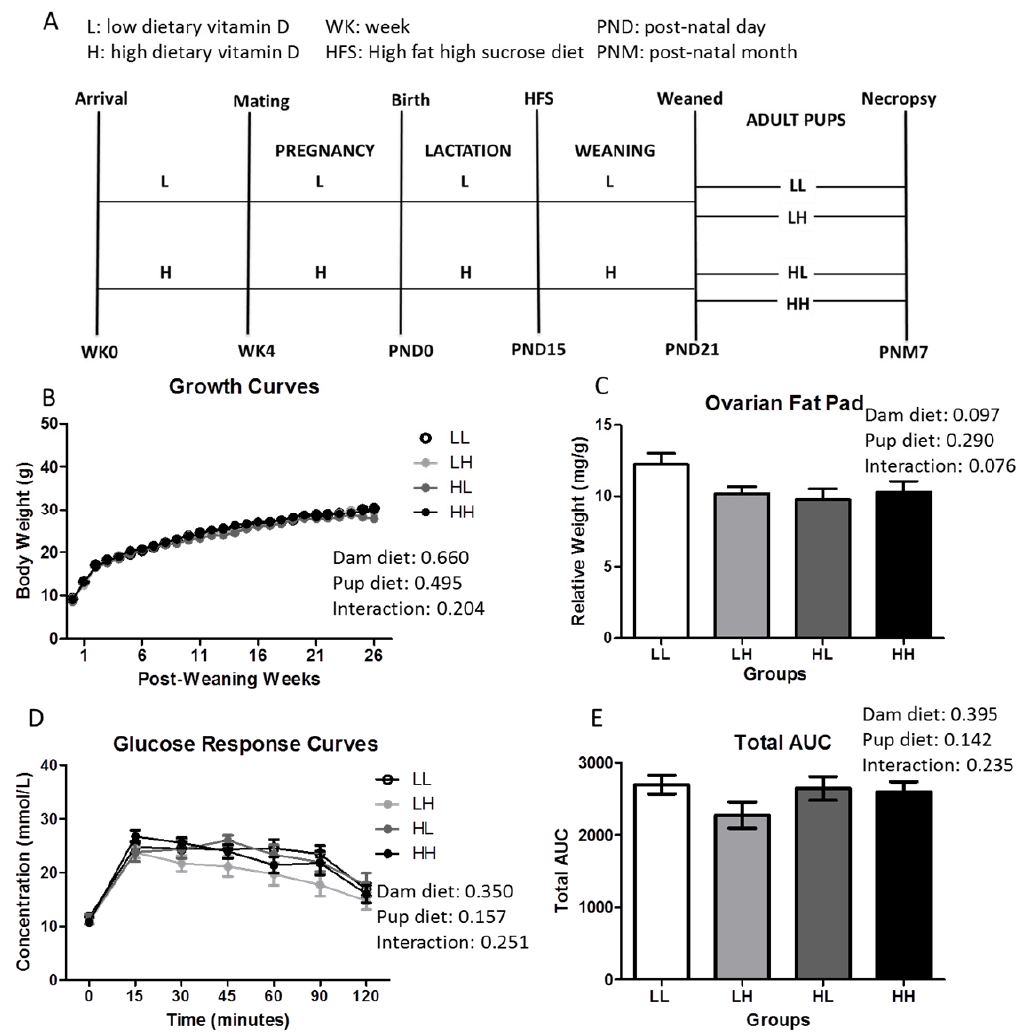
(Figure 1B), ovarian fat pad (OFP) relative weights (Figure 1C), fasting insulin (LL: 212.5 ± 34.0 pmol/L; LH: 206.4 ± 29.2 pmol/L; HL: 154.5 ± 23.9 pmol/L; HH: 153.7 ± 25.4 pmol/L; dam diet: p -value = 0.09, pup diet: p -value = 0.915, interaction: p -value = 0.934), and glycemic response curves and total area under the curve (Figure 1D,E, respectively) were not affected by high dietary vitamin D during in utero and lactation and/or post-weaning until seven months of age, independent of food intake (Figure A1; dam diet: p = 0.027, pup diet: p = 0.057, interaction: p = 0.001).